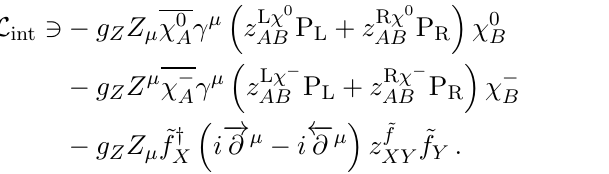
Table 2. The R-charges of the squarks and sleptons, neutralinos, antineutralinos and the (cid:31) - and (cid:26) -charginos. This table also shows which pairs of particles can couple to leptons or quarks. and sleptons, (cid:31) -charginos 2 and neutralinos can be written